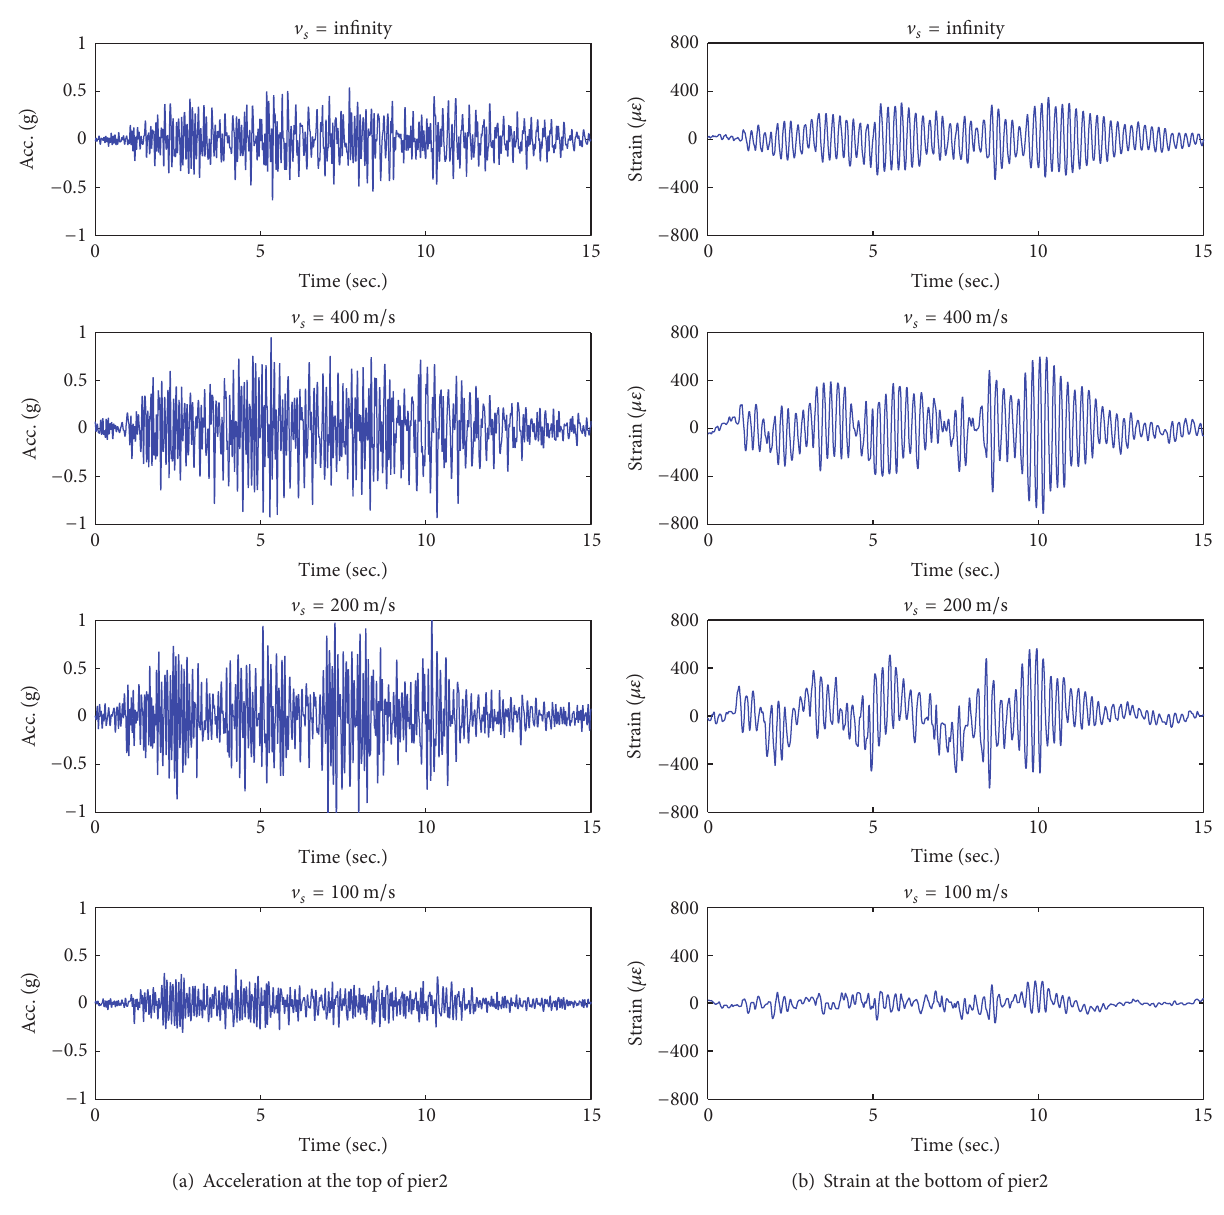
Figure 14: Dynamic response of bridge.